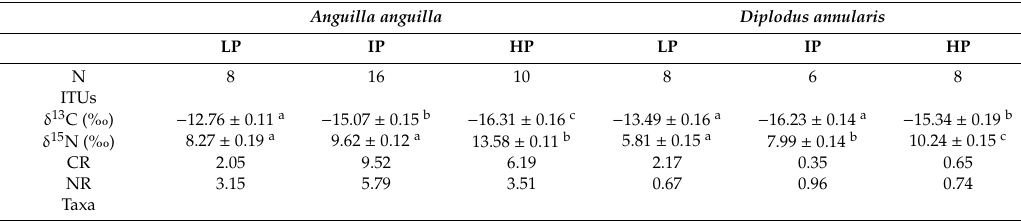
Table 2. Isotopic niche and food web metrics of the eel Anguilla anguilla and the seabream Diplodus annularis in each lake. LP: low, IP: intermediate, HP: high eutrophication. N: sample size, ITUs: Isotopic Trophic Units, δ 13 C (% (cid:24) ) and δ 15 N (% (cid:24) ) (mean ± s.e.), CR: Carbon Range, NR: Nitrogen Range, L: number of feeding links, S: number of ITUs in the diet, L / S: Linkage density, SEAc: Standard Ellipse Area “corrected” (SEAc) by degree of freedom, TNW: Trophic Niche Width. For details of metrics, please refer to the materials and methods section. For each parameter, di ff erent superscript letters (a,b,c) indicate di ff erences between lakes (Mann–Whitney test with Bonferroni correction for multiple comparisons; p -value <